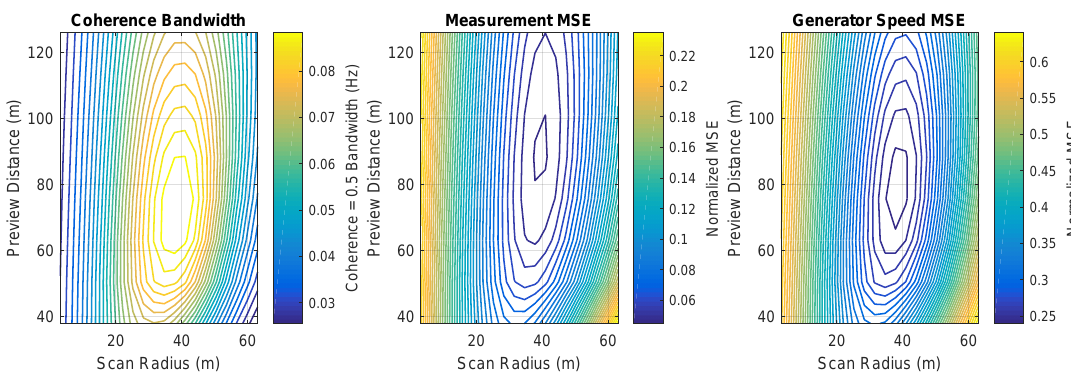
Figure 4. Dependence of coherence bandwidth, rotor effective wind speed measurement mean square error (MSE) (normalized by rotor effective wind speed variance), and linearized generator speed MSE (normalized by generator speed MSE with baseline feedback control) on scan radius r and preview distance d for the circular continuous wave (CW) lidar scan